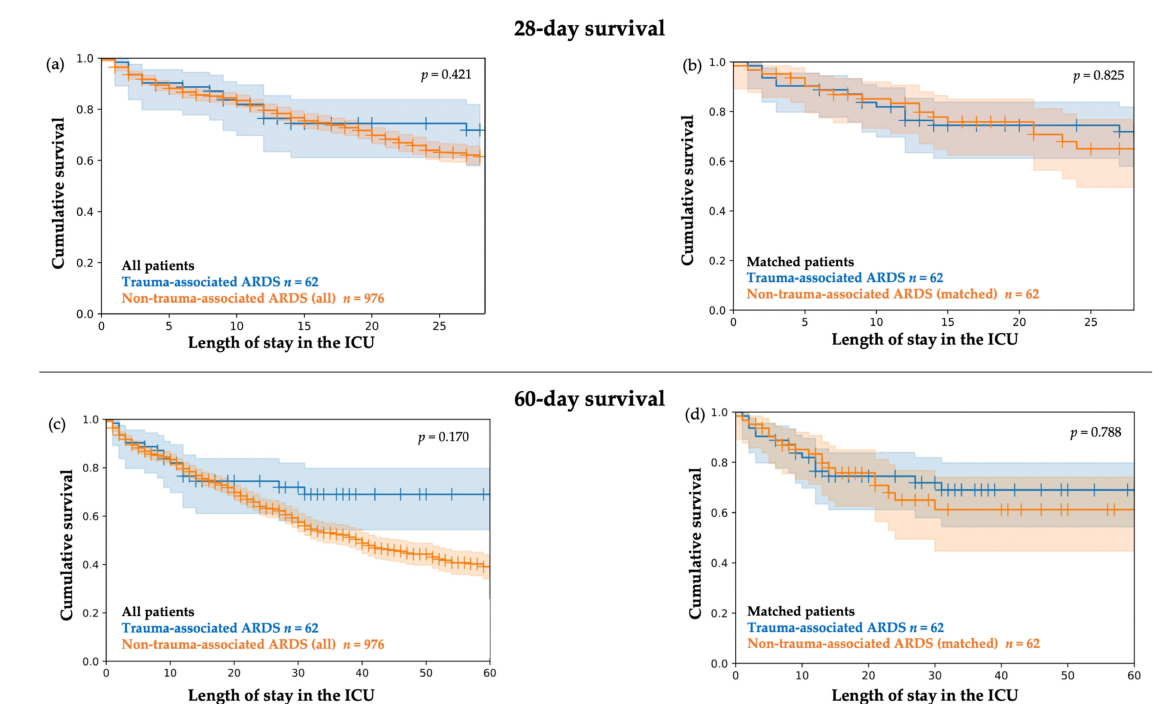
Figure 3. Kaplan–Meier plots. Cumulative 28-day in-hospital survival and 60-day in-hospital survival with 95% CI. ( a ) Cumulative 28-day survival in n = 62 patients with trauma-associated ARDS compared to n = 976 patients with non-trauma-associated ARDS. Tarone–Ware Test p = 0.421 ( b ) Cumulative 28-day survival in n = 62 patients with trauma-associated ARDS compared to n = 62 matched patients with non-trauma-associated ARDS. Tarone–Ware Test p = 0.825. ( c ) Cumulative 60-day in-hospital survival in n = 62 patients with trauma-associated ARDS compared to n = 976 patients with non-trauma-associated ARDS. Tarone–Ware Test p = 0.170 ( d ) Cumulative 60-day in-hospital survival in n = 62 patients with trauma-associated ARDS compared to n = 62 matched patients with non-trauma-associated ARDS. Tarone–Ware Test p =